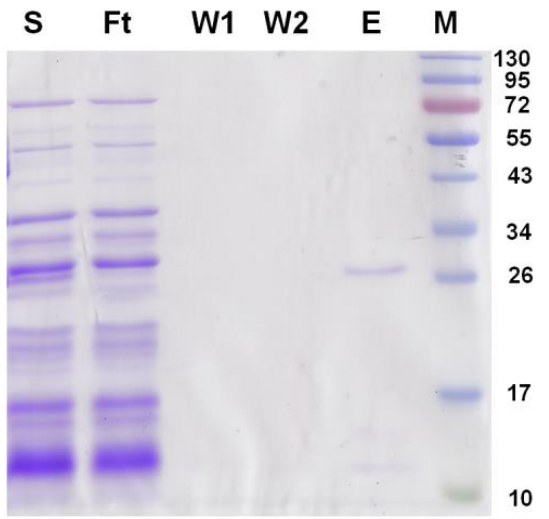
Figure 5. SDS-PAGE analysis of expression and purification of G6046-N ∆ 82-22b. Lanes S and Ft: the supernatant and flowthrough of G6046-N ∆ 82-22b; lanes W1 and W2: samples from the buffer wash; lane E: the eluted samples from the resin; lane M: molecular weight marker.